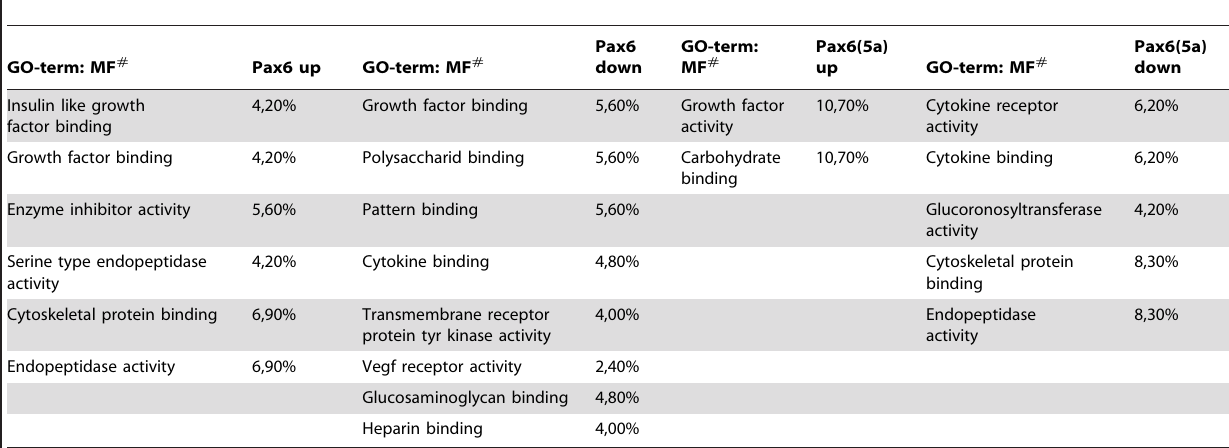
Table 3. Percentage of Pax6/Pax6(5a) up- or downregulated genes associated with various Molecular Function (MF) gene ontology terms.